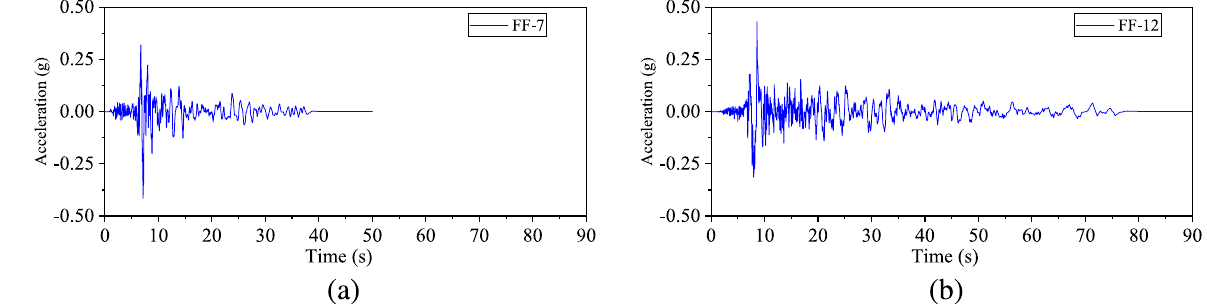
Fig. 24 Acceleration time history of ( a ) FF‑7 and ( b ) FF‑12 ground motion records (scaled to the MCE